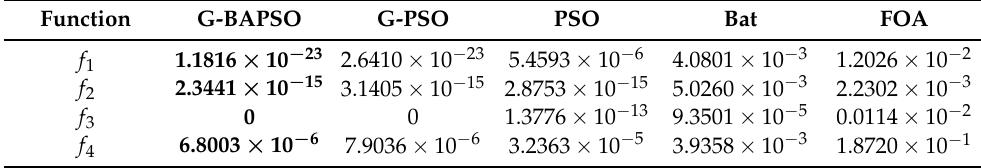
Table 5. The average error of the optimal solution in 200 experiments .